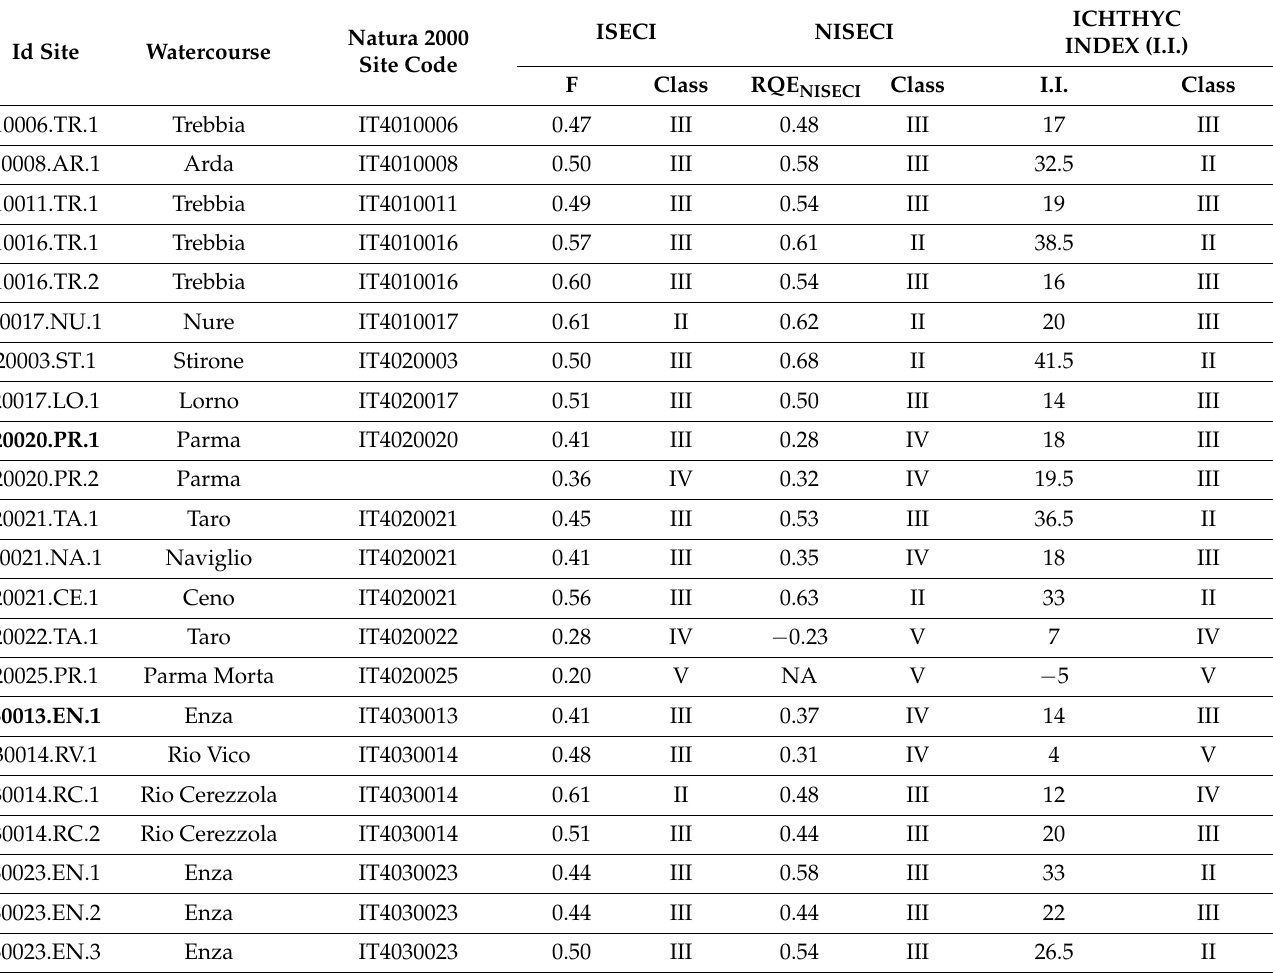
Table 4. Summary table of results obtained applying three different indices (ISECI, NISECI, I.I.); sites where brown trout was present and considered as an alien species in bold.